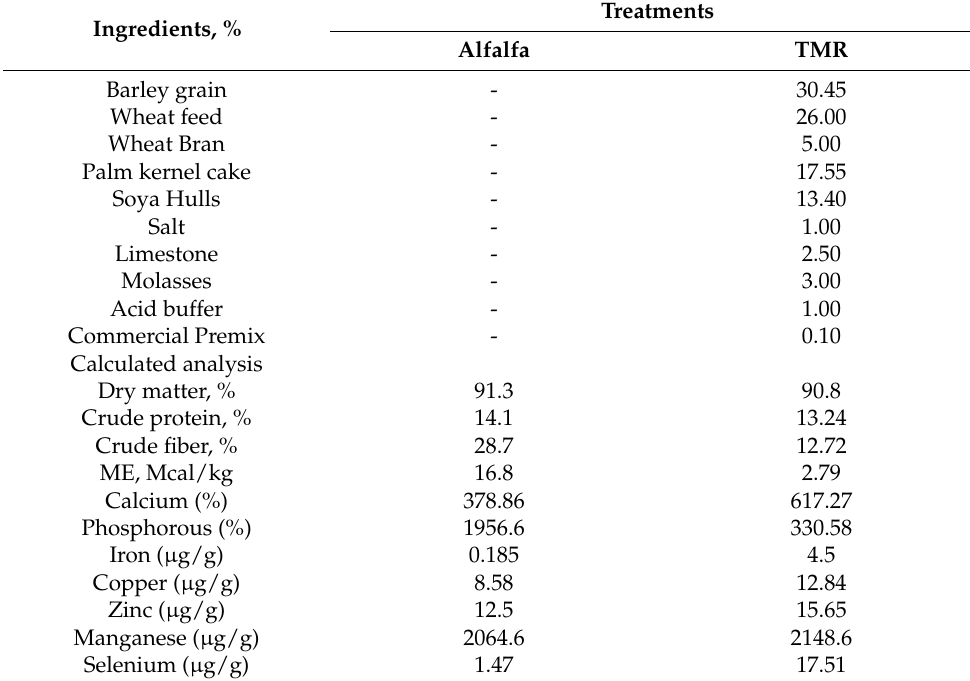
Table 1. Composition and calculated nutrient content of the experimental